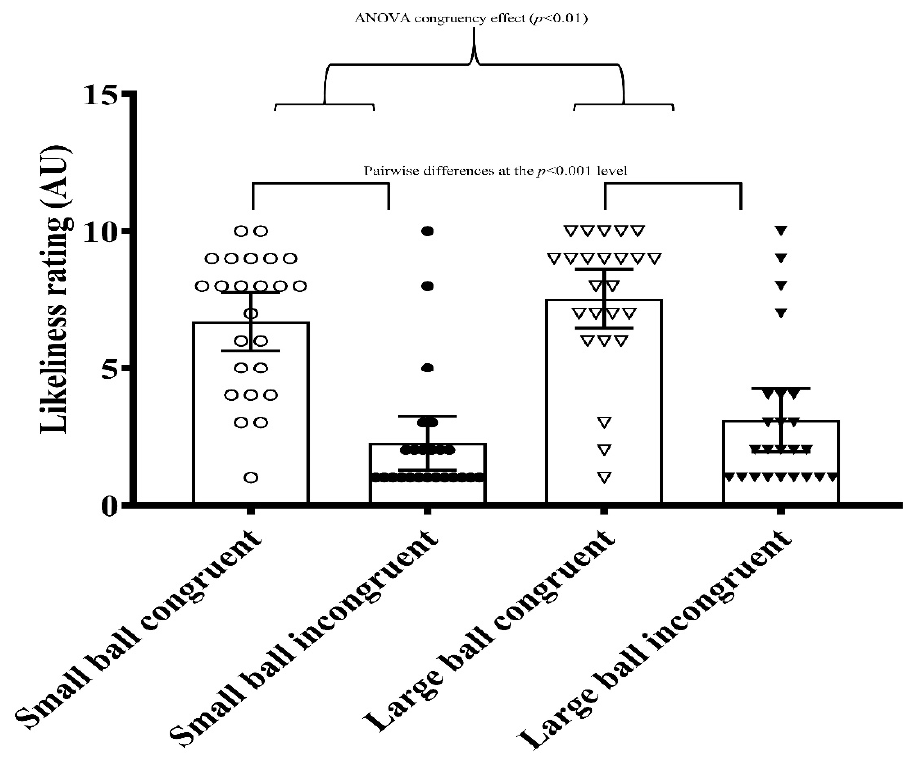
Figure 2. Mean ratings of small and large ball congruent and incongruent test events. Data are presented as grouped dot plots and mean and 95% confidence intervals. AU = arbitrary units.